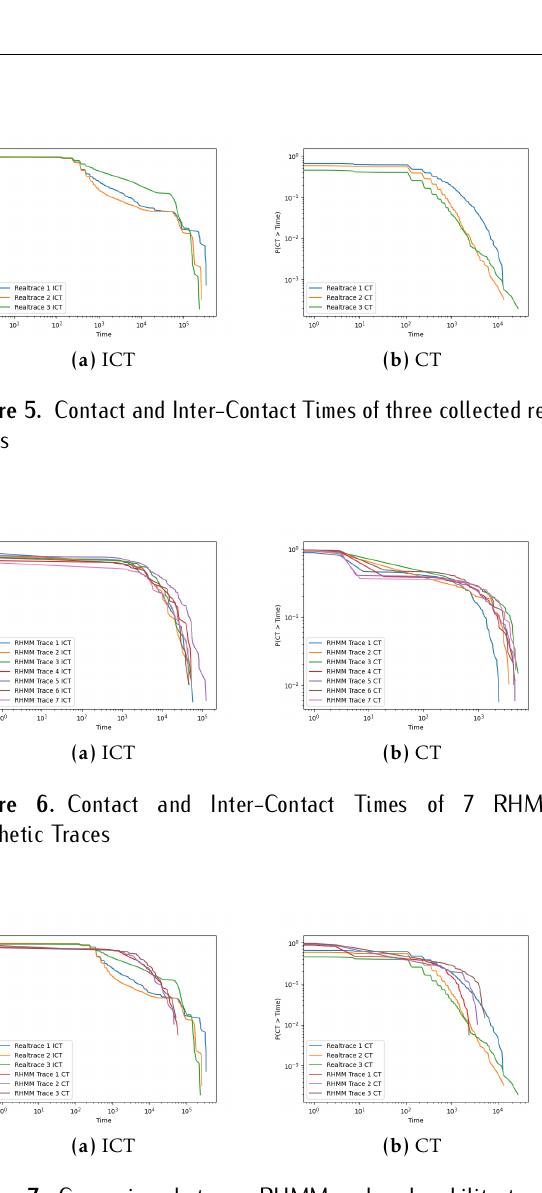
Figure 7. Comparison between RHMM and real mobility